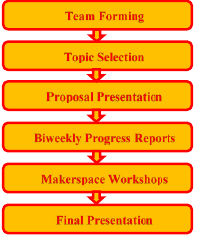
Fig. 3. APSC 1010 project